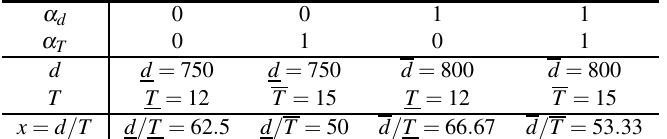
Table 2. Values of variables d , x , T for various border values of RDM-variables α d and α T